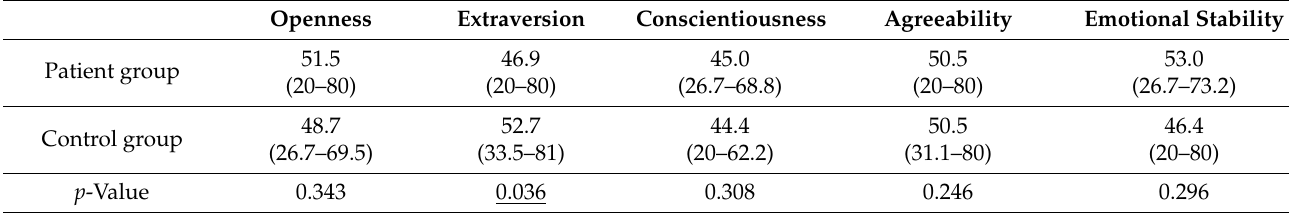
Table 3. Scores of the DECAS Personality Inventory.